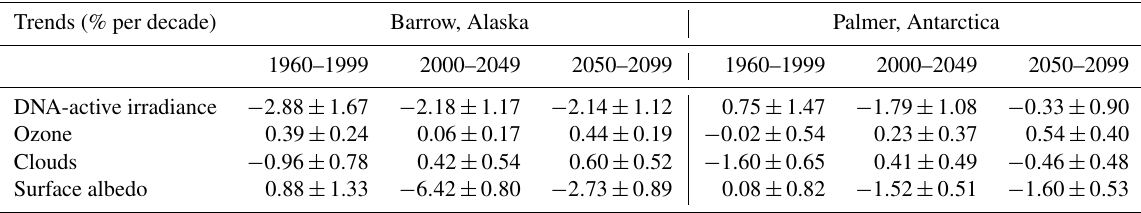
Table 7. Trends and their standard errors (% per decade) in the differences between the two model simulations – REF and FIX – for the DNA-active irradiance, total ozone, cloud cover, and surface albedo at Barrow (Alaska) and Palmer (Antarctica) for the periods